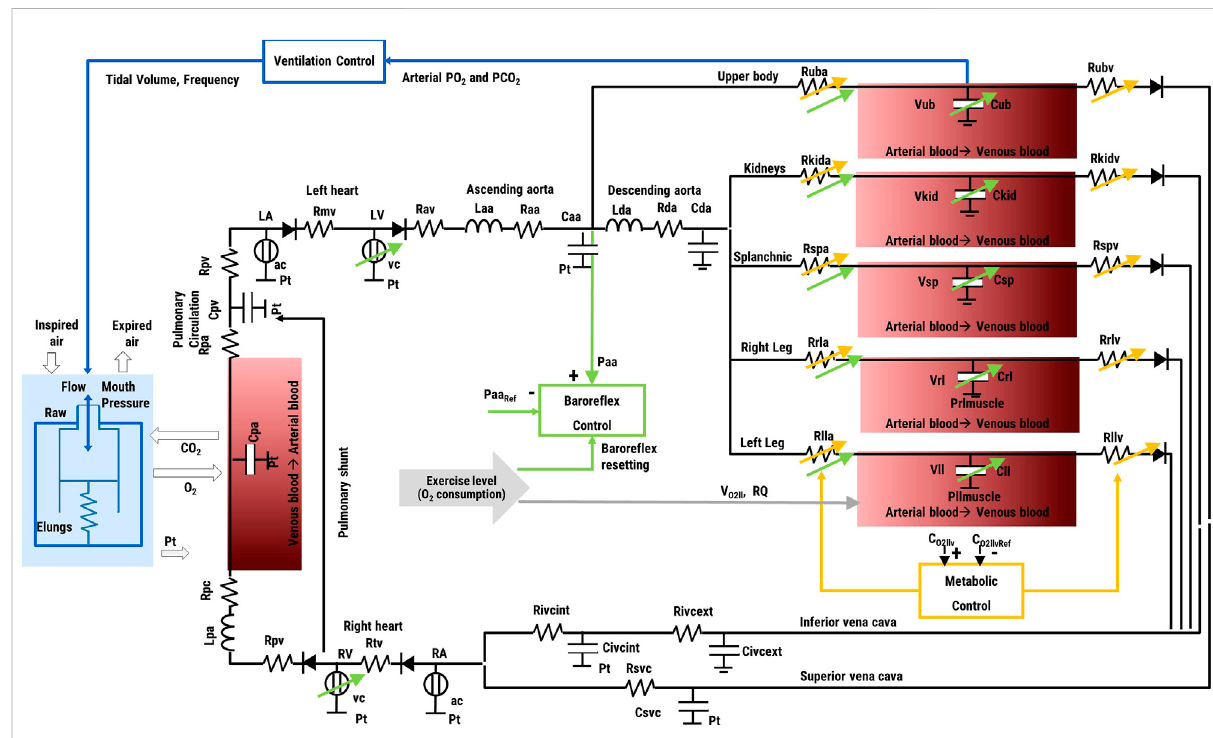
FIGURE 2 Schematic of the in silico simulator. Left and right atria ( LA , RA ) and ventricles ( LV , RV ) contraction is regulated by activation functions ( ac , vc ). Valves are represented by a diode and a resistance ( Rmv , Rav , Rtv , Rpv ). The i th vascular compartment is represented by resistance ( Ri ), inertance ( Li ), and compliance ( Ci ). Suf fi x refer to: ascending and descending aorta ( aa , da ), upper body ( ub ), kidneys ( kid ), splanchnic circulation ( sp ), left and right legs ( ll , rl ), inferior and superior vena cava ( ivc , svc ), arterial, and pulmonary circulation ( pa , pv ). The baroreflex control uses the